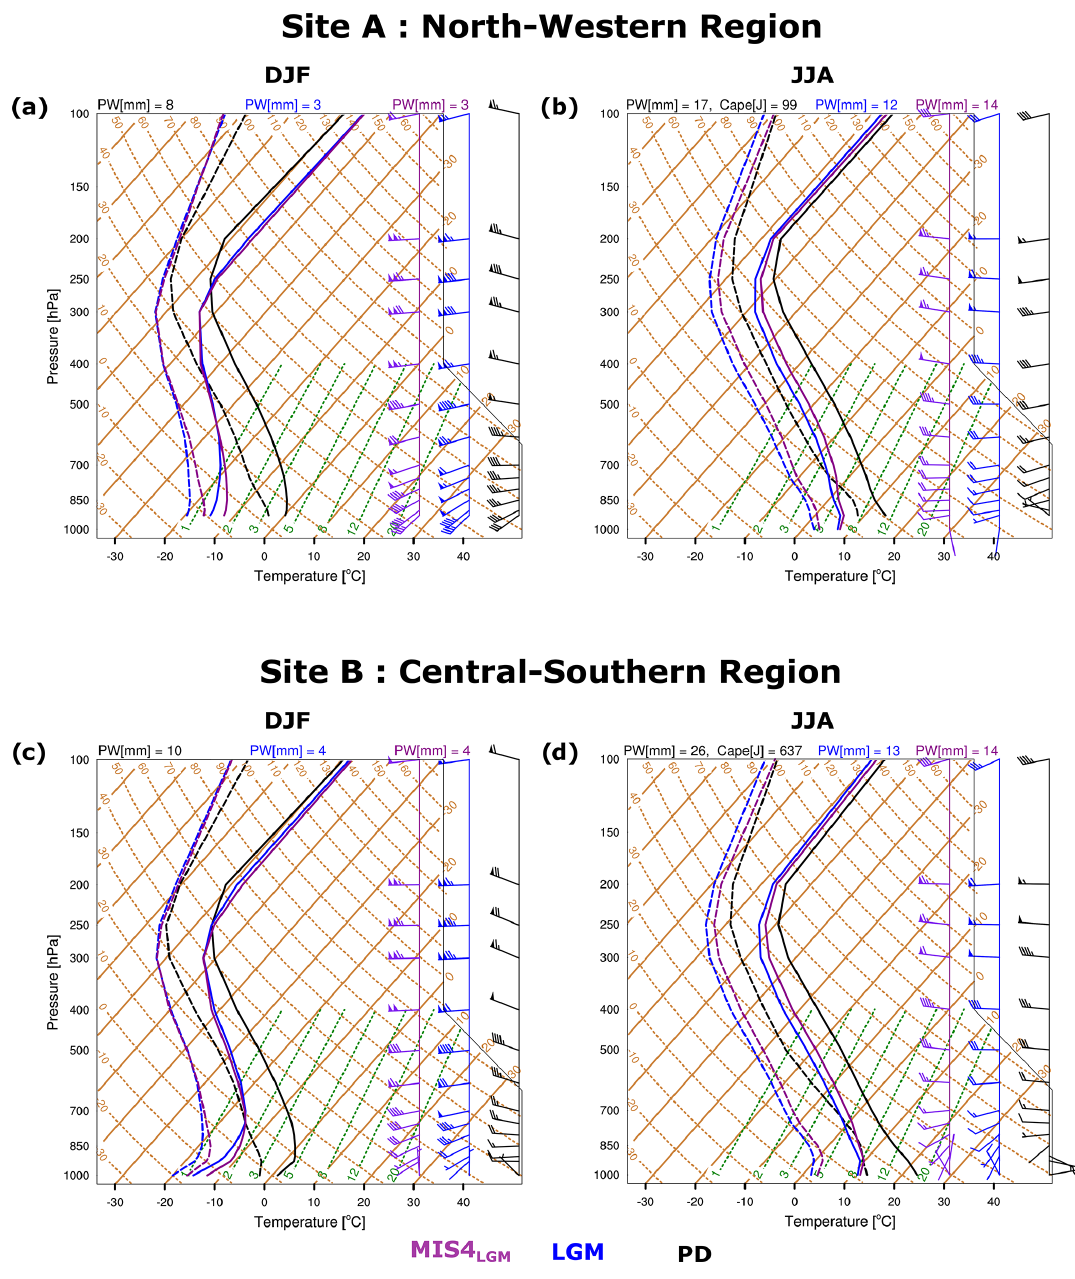
Figure 4. Skew–T diagram for site A (north-western region; a, b ) and site B (central-southern region; c, d ). Sites’ locations are shown in Fig. 2. Panels (a) and (c) represent climatological vertical profiles for DJF and (b) and (d) for JJA. MIS4 LGM climate is illustrated by purple lines, LGM climate by blue lines and PD climate by black lines. There are two vertical profiles for each climate: air temperatures in solid lines and dew-point temperatures in dashed lines. Skewed straight dashed green lines represent isohumes labelled on the bottom of the diagram. The mixing ratio is obtained from crossing the saturated mixing ratio lines crossed with the dew-point temperature vertical profile, and its value increases to the right at a constant pressure level. Solid brown lines are isotherms. Dry adiabatic lines (lines of equal potential temperature θ ) are slightly curved dashed brown lines. In the wind bars, the triangle, line and half-size line represent 50, 10, 5kmh − 1 , respectively. Furthermore, vertically integrated precipitable water (PW) and CAPE are given at the top of each panel. Note that CAPE is only displayed if it is different from zero. Please see Sect. 3 for a in-detail description of the Skew–T diagram.